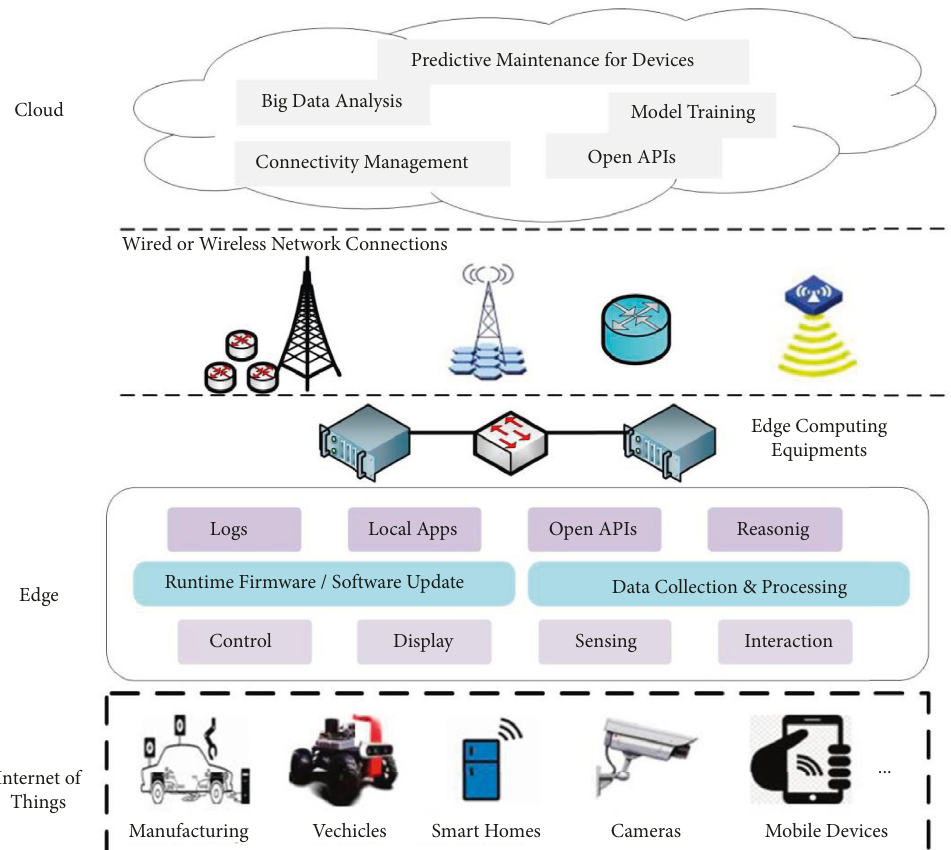
Figure 1: Framework of art and painting course teaching auxiliary system based on edge